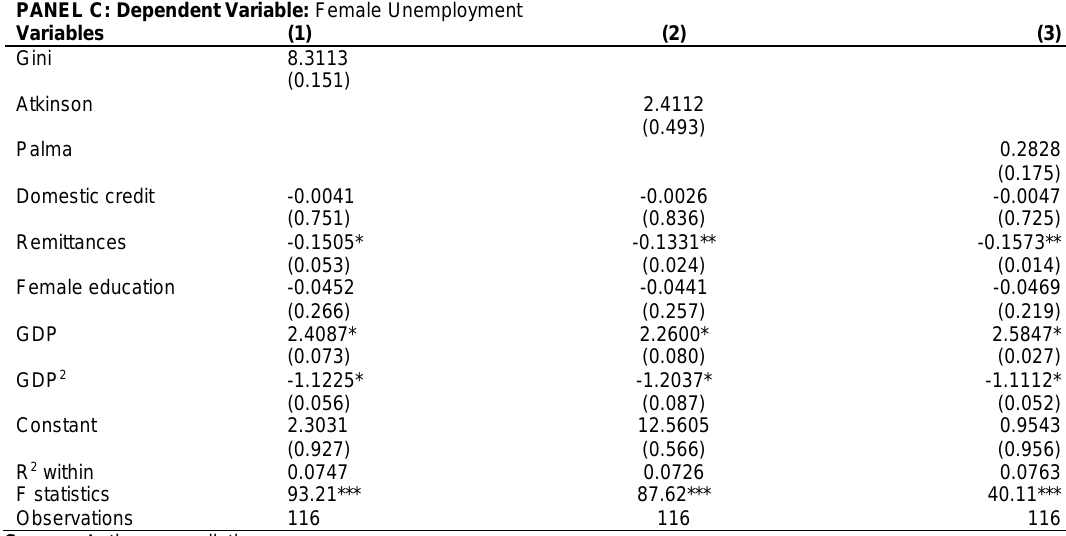
Table 5. Instrumental Variable Fixed Effects Results